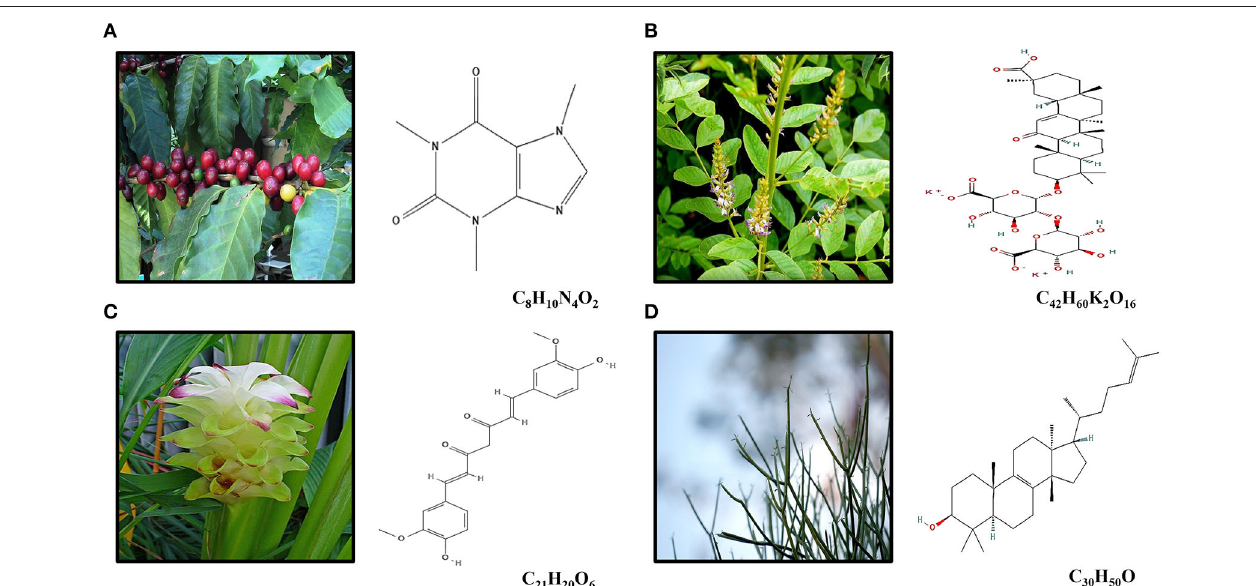
FIGURE 1 | (A) Caffeine (C 8 H 10 N 4 O 2 ) is an alkaloid occurring naturally in some 60 plant species, of which cocoa beans, kola nuts, tealeaves, yerba maté, guarana berries, guayusa, yaupon holly, and coffee beans are the most well-known. The best-known source of caffeine is the coffee bean, the seed of the coffee plant. (B) Licorice root ( Glycyrhiza glabra ) is widely used in traditional Chinese medicine for its pharmacological and physiological action as antiallergic, antibiotic, antiinflammatory, and antitumor effects. DPG (C 42 H 60 K 2 O 16 ) is a dipotassium salt of GA, a compound isolated from licorice root. (C) Curcumin (diferuloylmethane; C 21 H 20 O 6 ) is the main compound found in turmeric, an Indian spice derived from Curcuma longa Linn , which presents antioxidant and antiinflammatory effects. (D) The euphol (C 30 H 50 O), a tetracyclic triterpene alcohol, is the main constituent of the Euphorbia tirucalli known as aveloz.